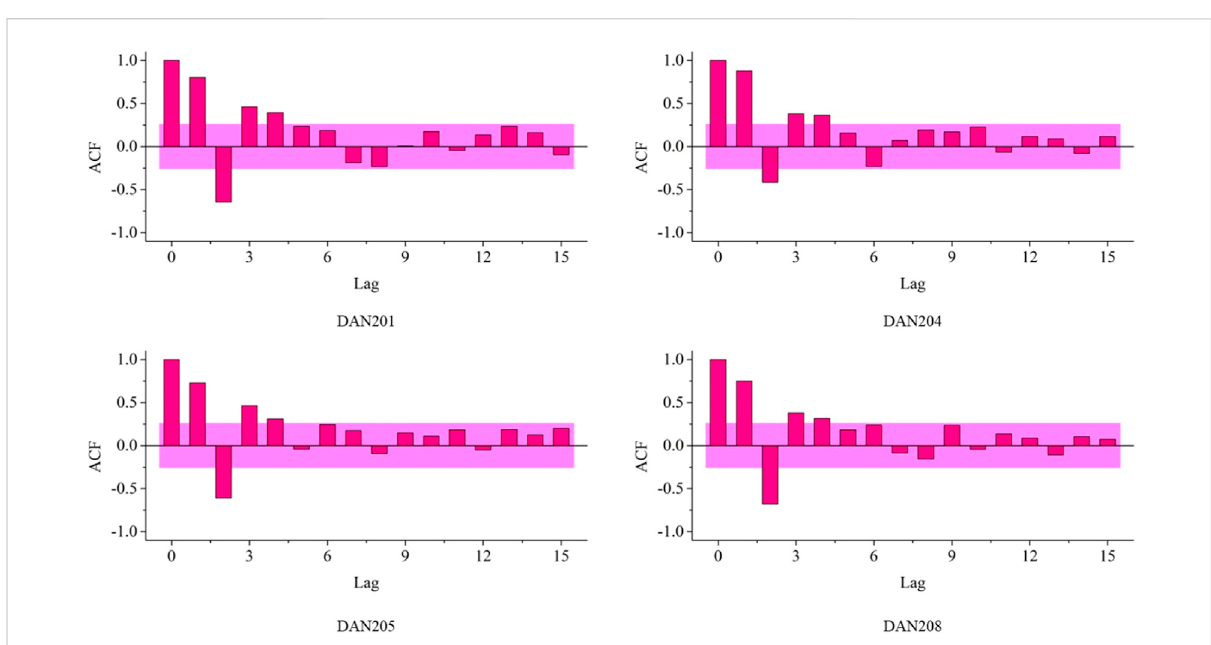
FIGURE 2 ACFs and the threshold based on Ljung – Box